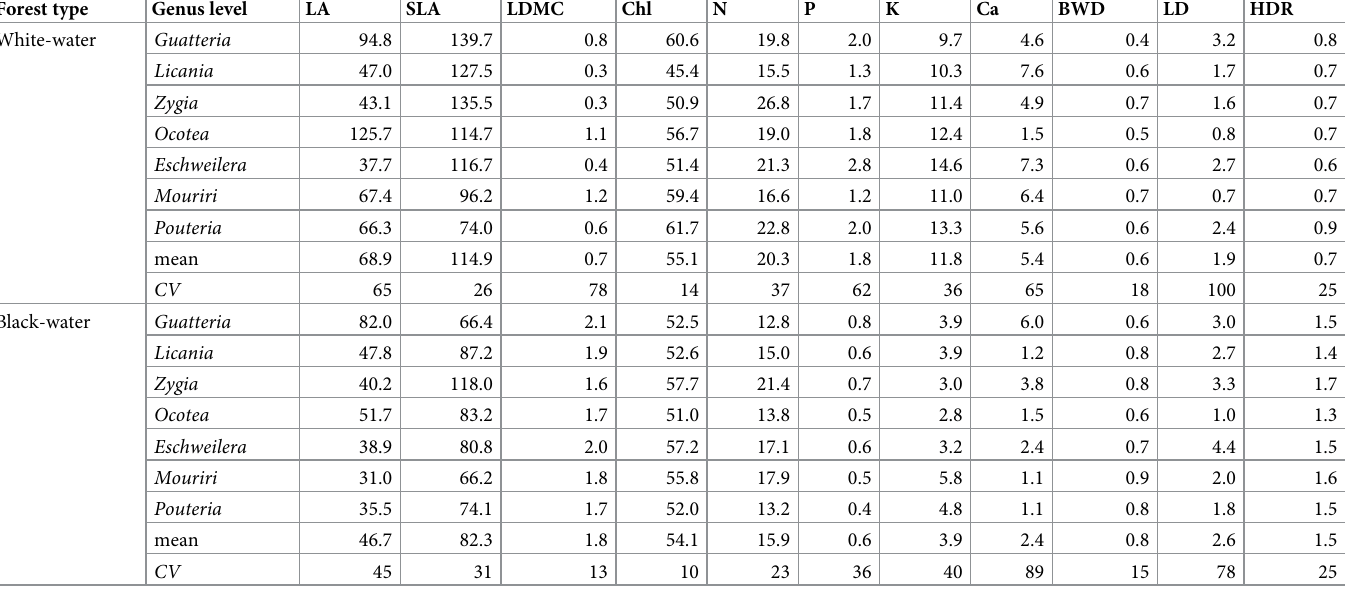
Table 3. Mean values of 11 functional traits of seven genera in white-water and black-water forests. The columns indicate trait mean values per genus: leaf area (LA), specific leaf area (SLA), leaf dry matter content (LDMC), leaf nitrogen (N), leaf phosphorus (P), leaf potassium (K), leaf calcium (Ca), branch-wood density (BWD), lenticel density (LD), height:diameter ratio (HDR). Trait mean values are based on 5 individuals per genera and coefficient of variation ( CV ) is based on all 33 species per forest type (see Table 2 for trait